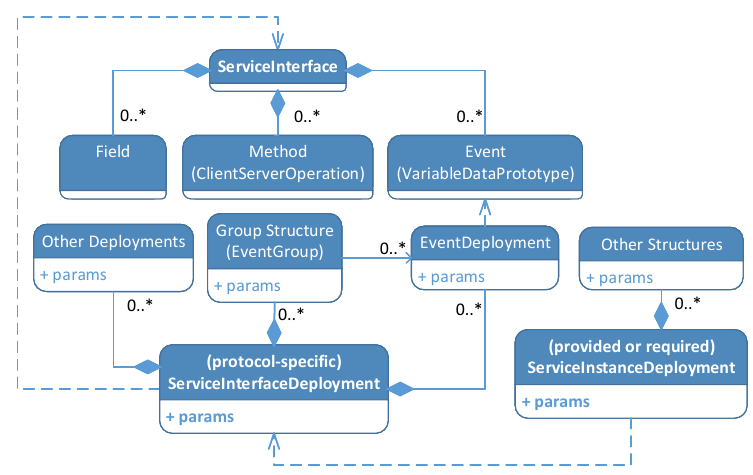
Figure 10. Protocol-specific ServiceInterfaceDeployment and ServiceInstanceDeployment in AU- TOSAR Adaptive, see [42]. (0..*) denotes the association to none or at least one object.